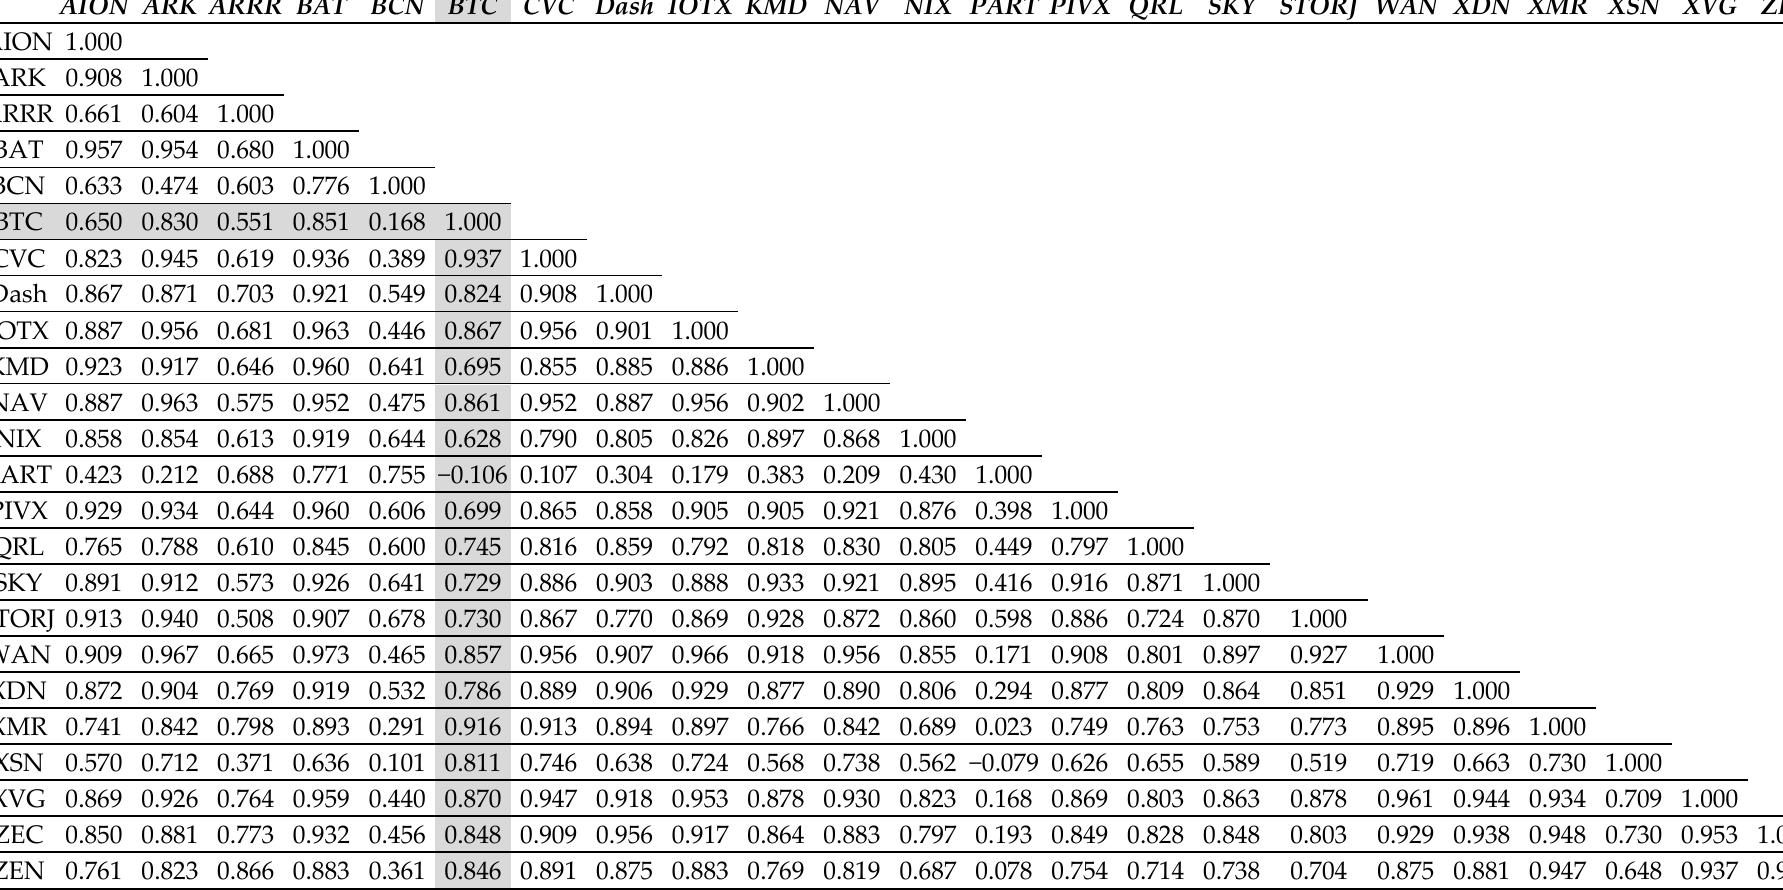
Table 4. Correlation coefficients of analyzed cryptocurrencies in time period from 1 January 2019 to 18 June 2021 (all privacy coins have statistically significant correlation with BTC and this with p value of <0.01).